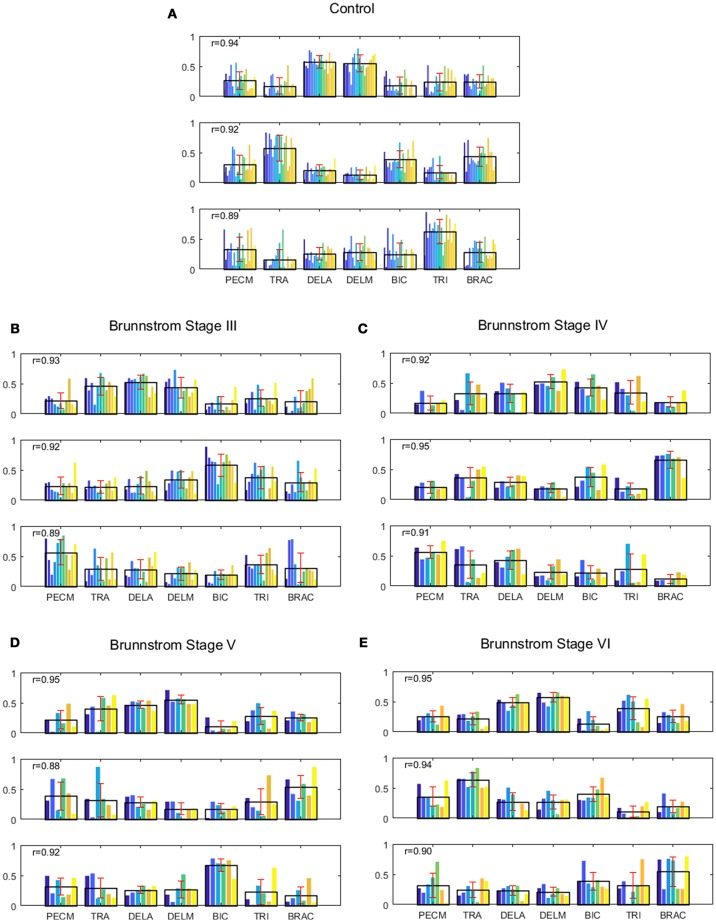
Muscle synergies extracted from control group (A) and Brunnstrom Stage III to VI in stroke survivors (B–E). (A) In control group, three synergies were identified by the algorithm of NMF from the EMG signals of each subject. Colorized bars show the relative weighting of a muscle and black bars with red represent group means and standard deviations. (B–E) In stroke survivors (Brunnstrom Stage III to VI), three synergies were identified from affected-arm of stroke survivors. The r-value in each subpanel represents the mean similarity across all matched pairs of synergies within each group calculated by scalar product.